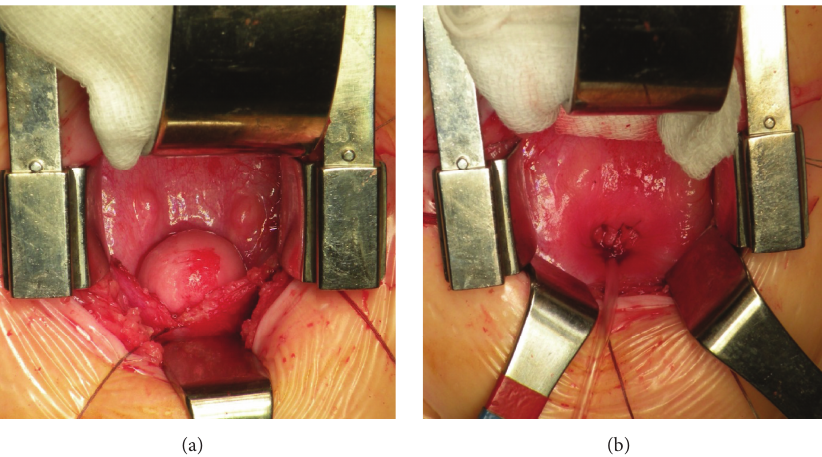
Figure 3: Intraoperative images. (a) Intraoperative appearance of the vesical trigone, ureteral orifices, and the mass occupying the bladder neck; (b) the mass is removed and the bladder mucosa sutured. An indwelling catheter is inserted as urethral tutor.